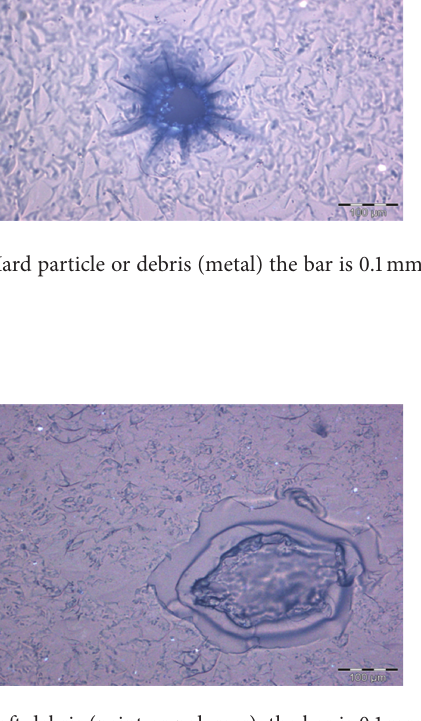
Figure 9: Soft debris (paint or polymer); the bar is 0.1 mm (CNES